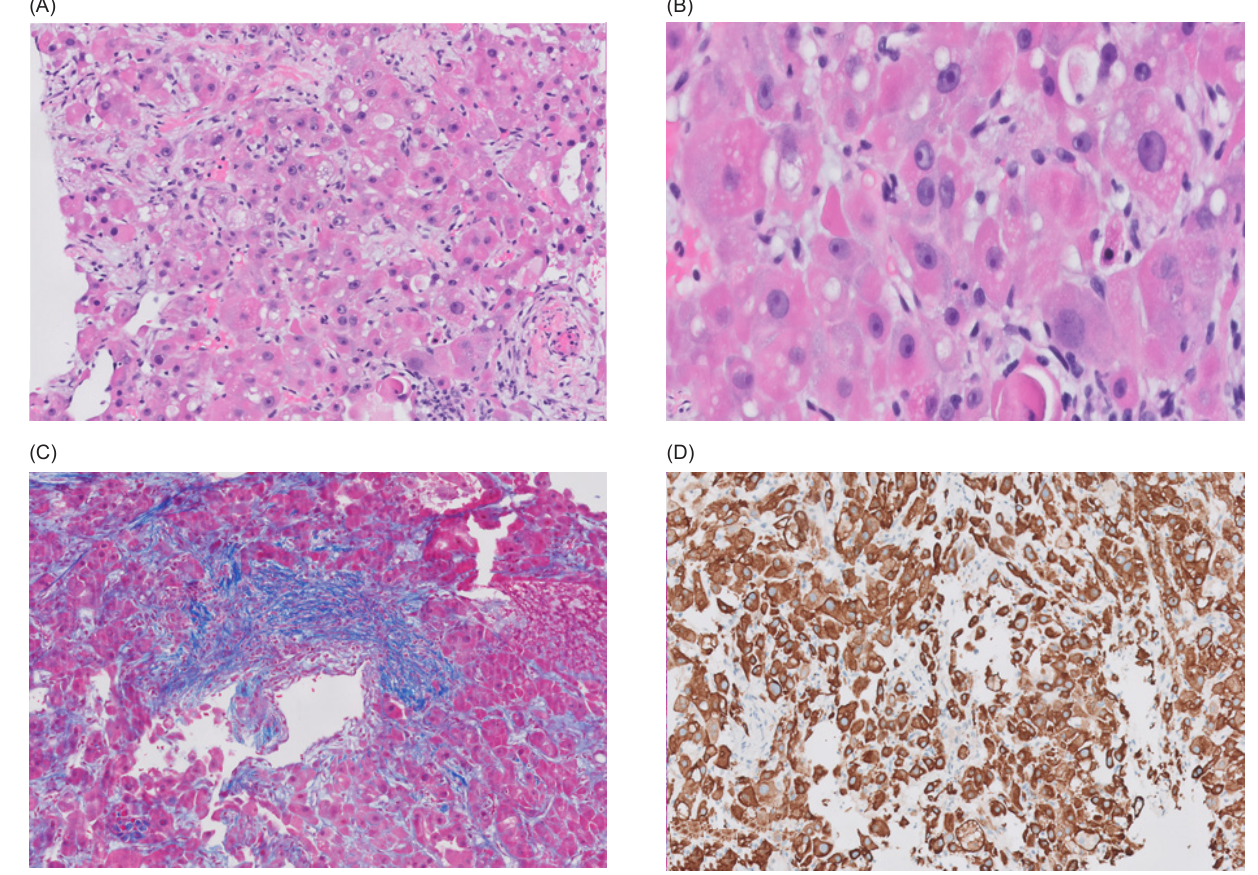
Figure 2: (A) Fibrolamellar carcinoma with sheets of neoplastic cells and intratumoral fibrosis (Hematoxylin and eosin, 10× magnification); (B) Polygonal cells with abundant granular eosinophilic cytoplasm, pale bodies, nuclei with open chromatin, and prominent macronucleoli (Hematoxylin and eosin, 40 × magnification); (C) Intratumoral fibrosis highlighted by trichrome stain (10 × magnification); (D) Neoplastic cells show diffuse intense positive staining with cytokeratin 7 (Hematoxylin and eosin, 20 ×